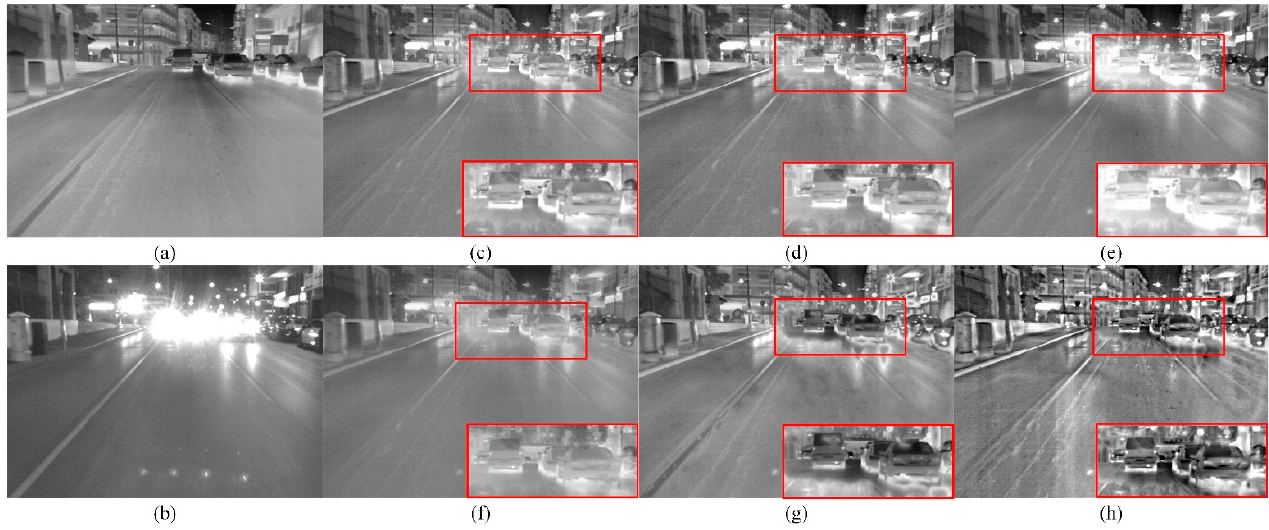
Figure 1. Fused images in the glare scene using six different methods. ( a ) Infrared image; ( b ) Visible image; ( c ) MDLatLRR; ( d ) MGFF; ( e ) MSID; ( f ) ResNet; ( g ) RGFF; ( h ) Proposed.